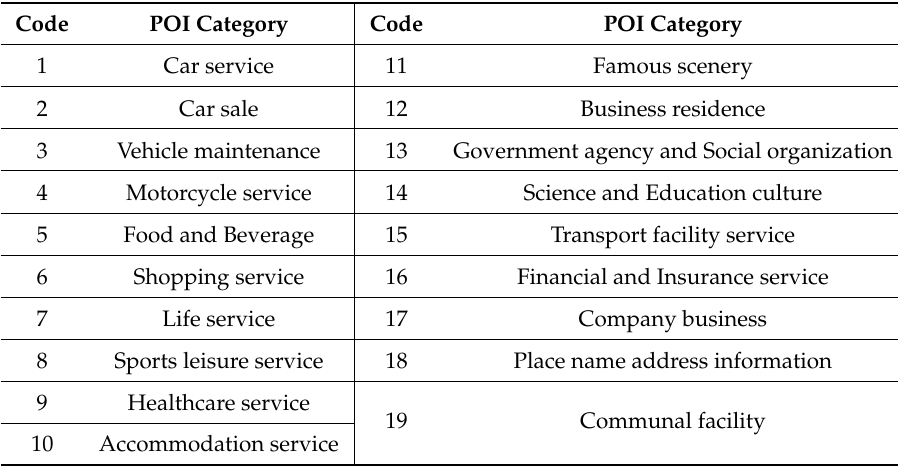
Table 2. POI category